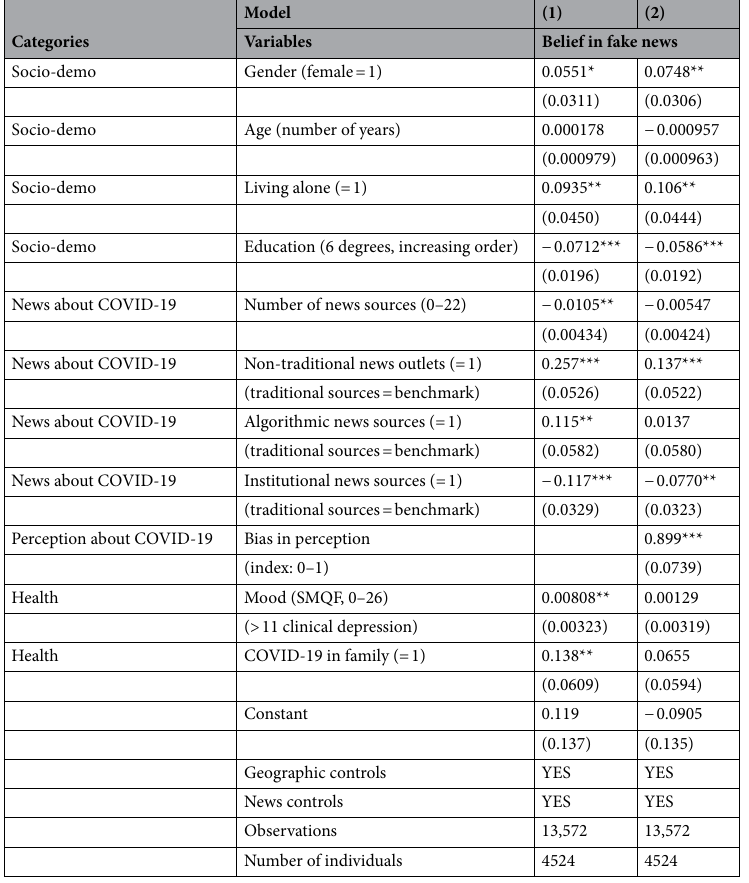
Table 1. Result of probit panel data models. *The estimates in the table refer to probit panel data models, with robust standard errors. The dependent variable is 1 when the individual erroneously believes in fake news. For each variable, the coefficient, the standard error (in parentheses), and the level of significance are reported as follows: *** significant at 99%; ** significant at